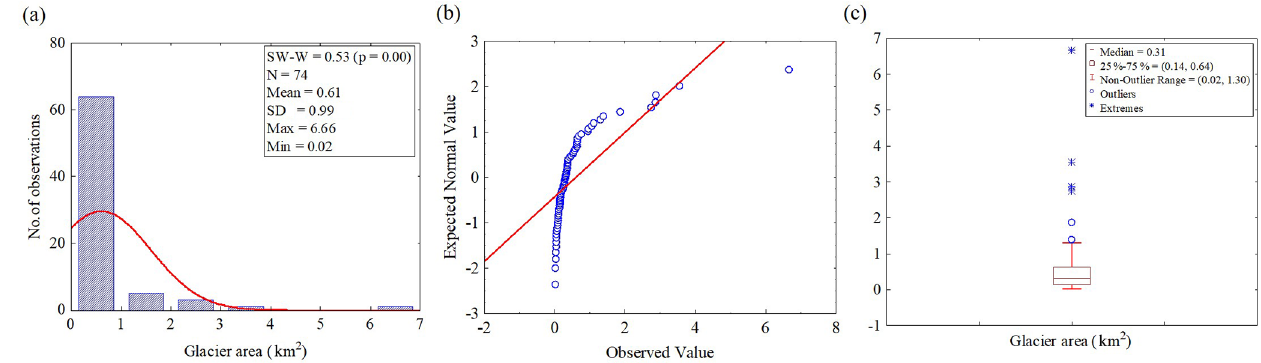
Figure 5. Distribution of glaciers in the CCW of the upper Tista basin, the Sikkim Himalaya (2018): (a) histogram of glacier areal distribu- tion, (b) normal Q – Q plot of glacier area, and (c) box-and-whisker plot of glacier surface area. Table 2. Topographic parameters according to different size classes (2018) for the CCW based on Sentinel-2A and the SRTM DEM. Parameters